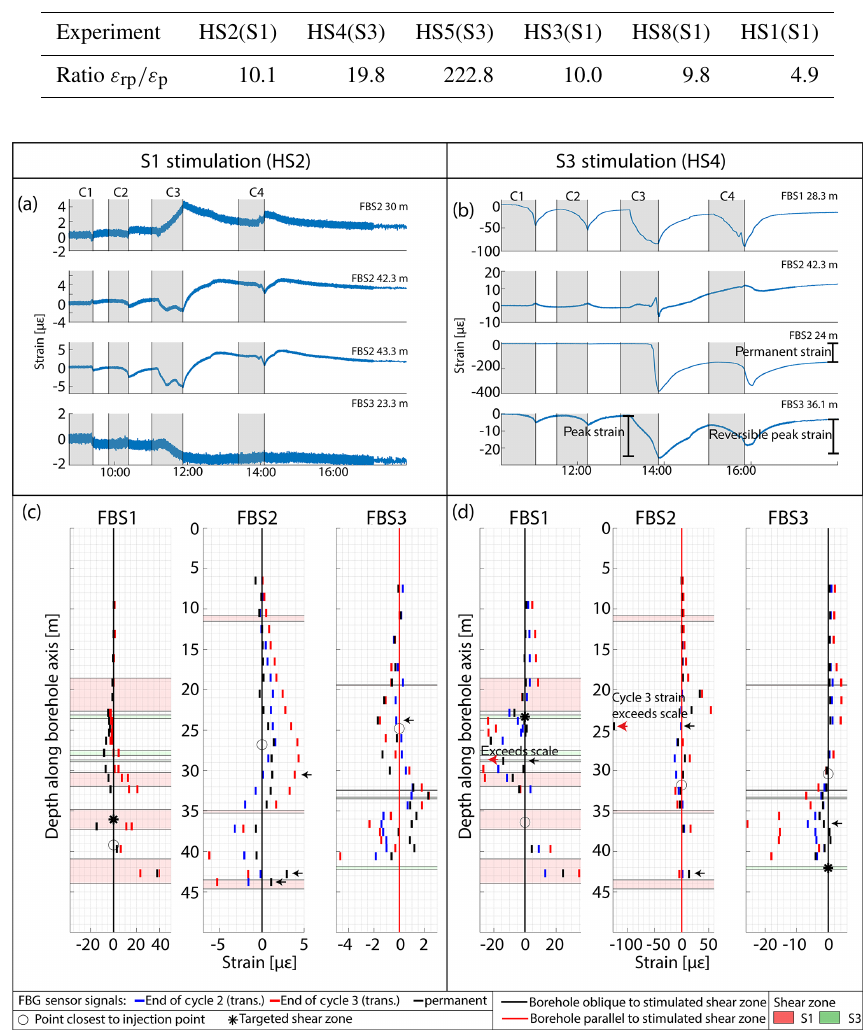
Figure 9. (a, b) Examples of strain time series from four FBGs during HS2 and HS4, respectively. The vertical shading denotes periods of injection during the four cycles. Examples of the permanent strain, the peak strain and the reversible peak strain are indicated on the HS4 strain codas. (c, d) Profiles of permanent strain and strain at the end of the injection phases of C2 and C3 along the three FBS boreholes for HS2 and HS4, respectively. The open circle along each borehole denotes the location closest to the injection point for the experiment in question. The pink and green bands indicate places where the holes cut S1 and S3 shear zones, respectively. The small black arrows indicate the sensors whose strain codas are shown in (a) and (b)